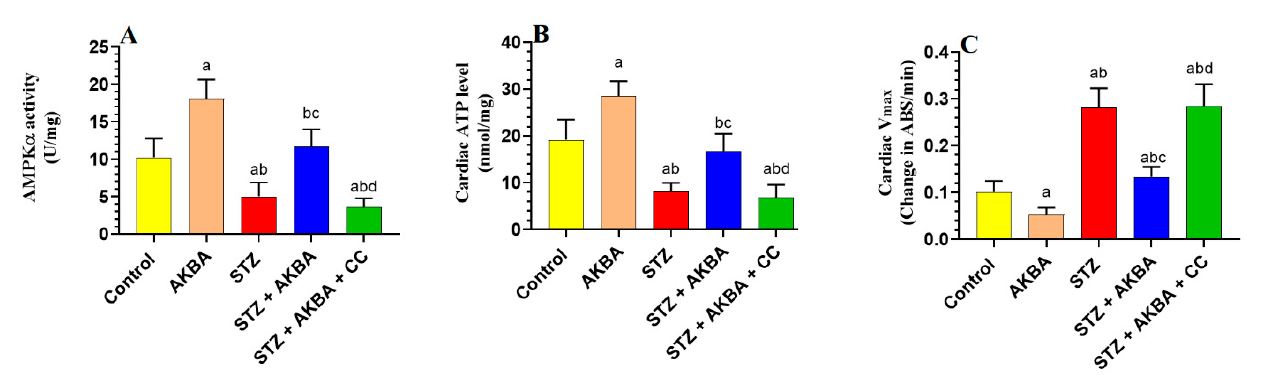
Figure 2. Activities of AMPK α ( A ), total levels of ATP ( B ), and the maximum reduction of Vmax as a marker of mitochondrial membrane potential (mtPTP) opening ( C ) in the left ventricles (LVs) of all rat groups. Data were analyzed with one-way ANOVA followed by Tukey’s test. Values are presented as mean ± SD (n = 8/group). Data were considered significantly different at p < 0.5. a: significantly different as compared to control rats; b: significantly different as compared to AKBA-treated rats; c: significantly different as compared to STZ-diabetic rats; d: significantly different as compared to STZ + AKBA-treated rats. CC—compound C (a selective AMPK inhibitor).